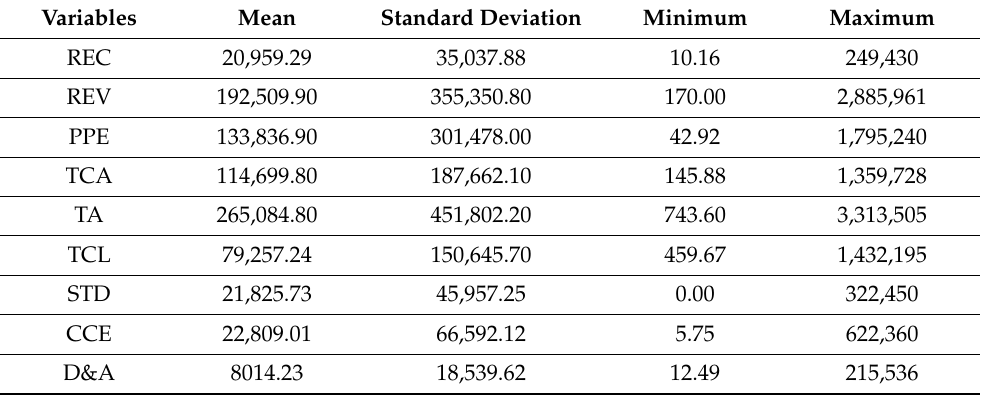
Table 1. Summary Statistics of the variables used in the study (in million rupees).